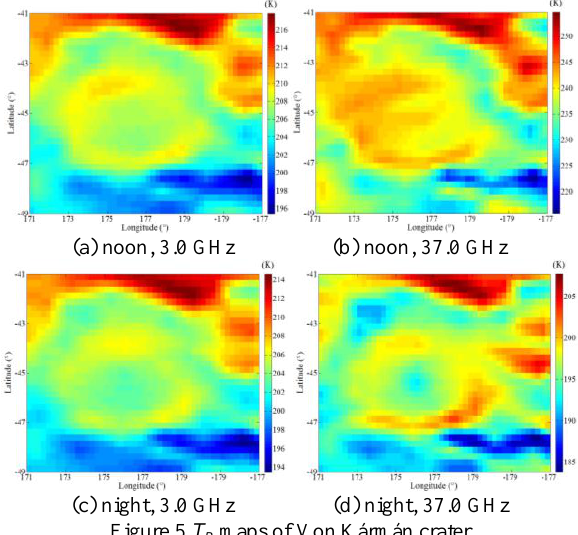
Figure 5 T B maps of Von Kármán